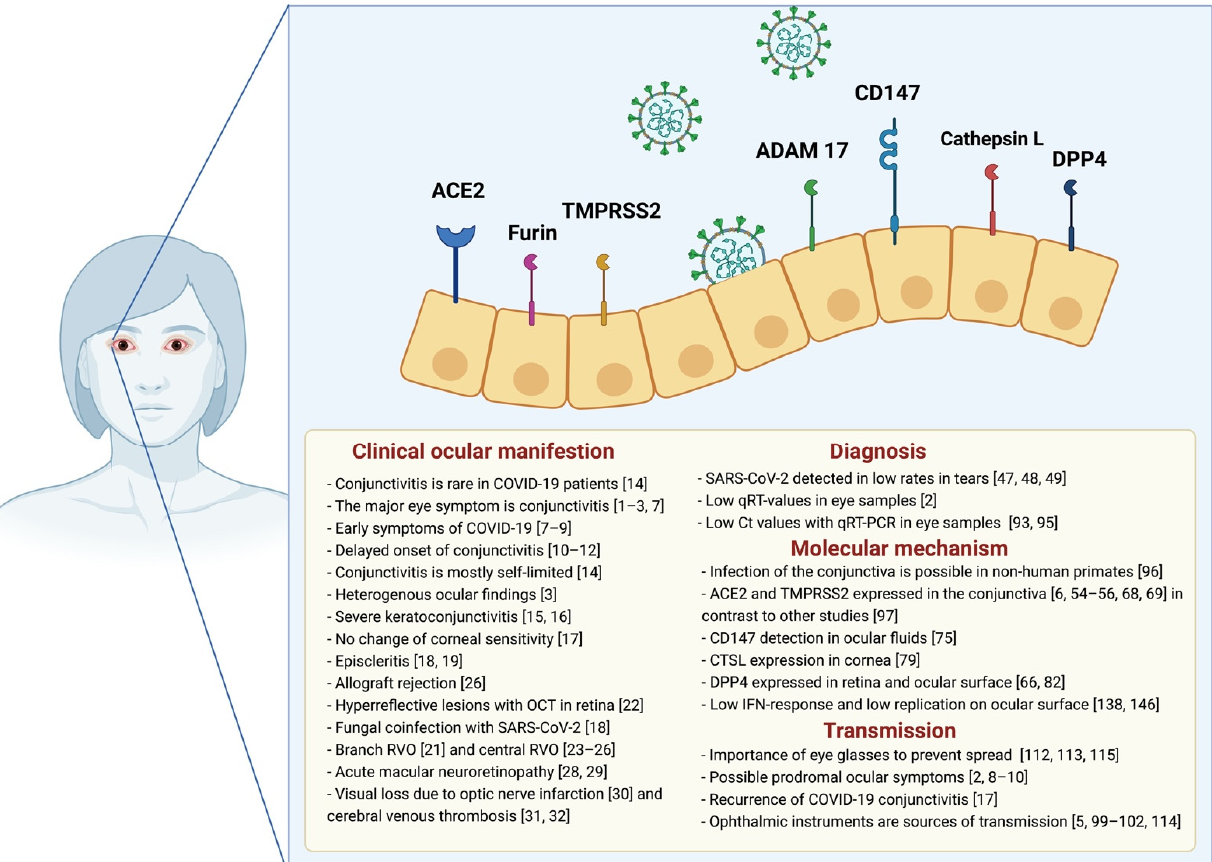
Figure 1. Overview of SARS-CoV-2 entry molecules, clinical manifestations, and transmission on the ocular surface with references. Figure created with BioRender.com. COVID-19: Coronavirus disease 2019, SARS-CoV-2: Severe acute respiratory syndrome coronavirus 2, OCT: Optical Coherence Tomography, RVO: Retinal Vein Occlusion, qRT-PCR: Quantitative reverse transcription polymerase chain reaction, Ct: Cycle threshold, ACE2: Angiotensin-converting enzyme 2, TMPRSS2: Transmembrane serine protease 2, CTSL: Cathepsin L, DPP4: Dipeptidyl peptidase-4, IFN: Interferon.